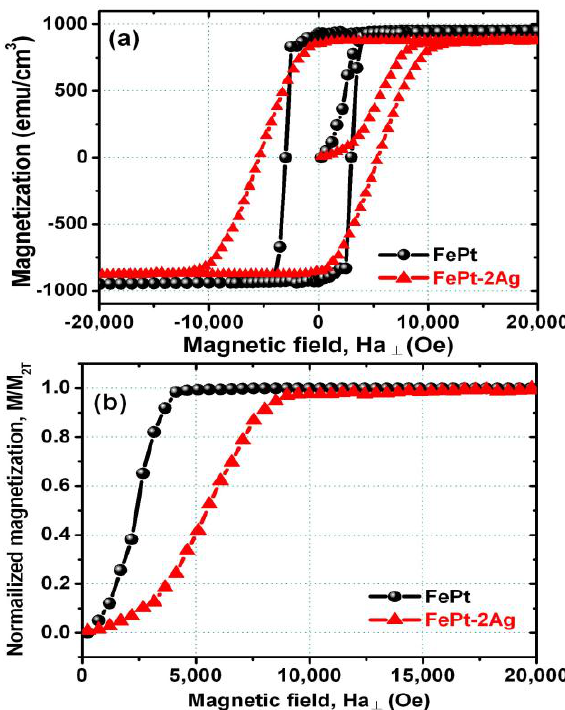
Figure 3. ( a ) Out-of-plane magnetization curves and corresponding ( b ) normalized initial magnetization curves for the [Fe/Pt] 18 multilayer films without and with insertion of two ultrathin Ag (0.5 nm each) nanolayers.